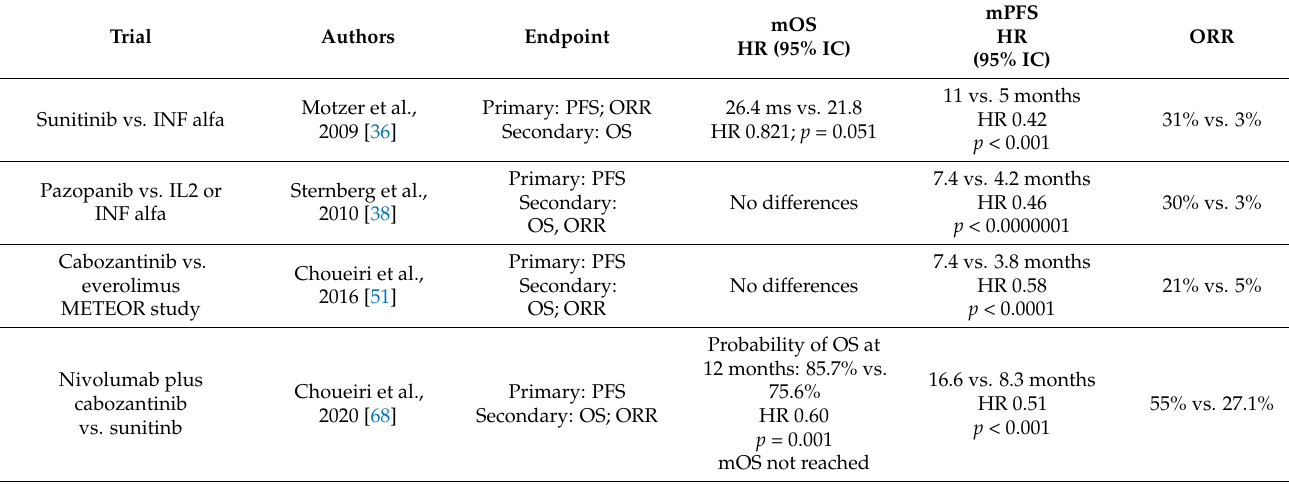
Table 5. Single drugs and combinations approved for metastatic